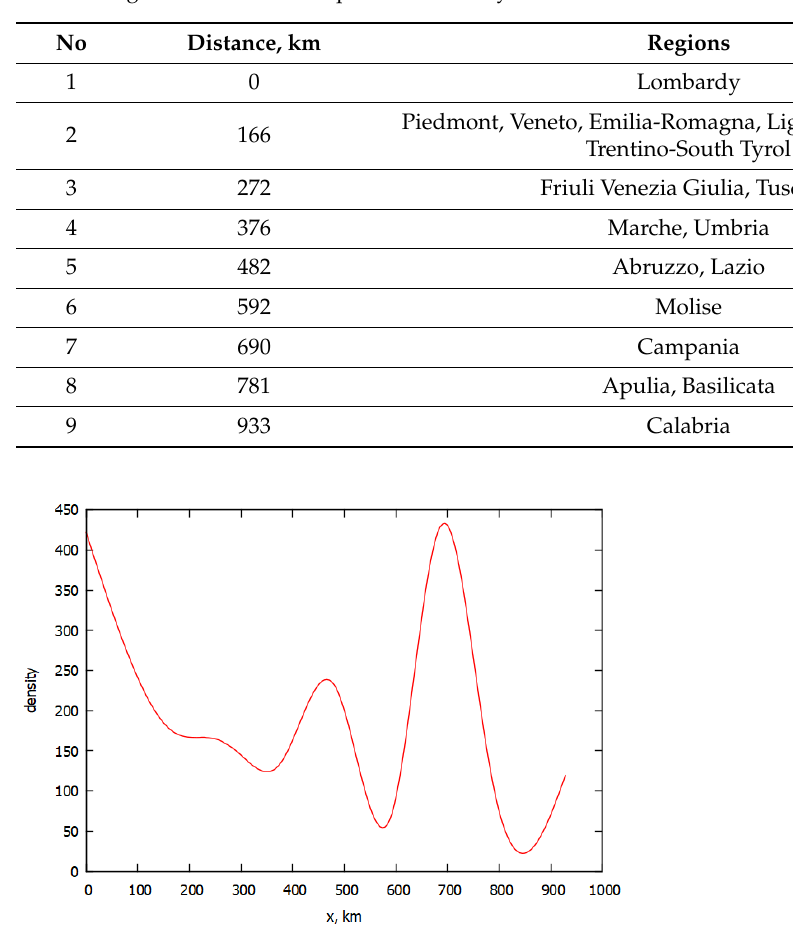
Figure 1. Linear density of population in Italy. The graph was plotted through 9 points that correspond to each band and was interpolated with cubic splines.